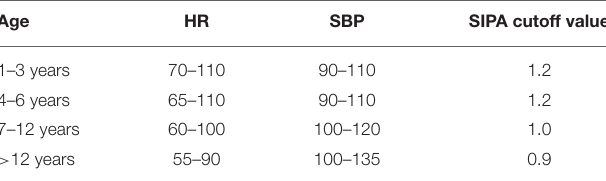
TABLE 1 | Vital signs by age with the calculated SIPA cutoff